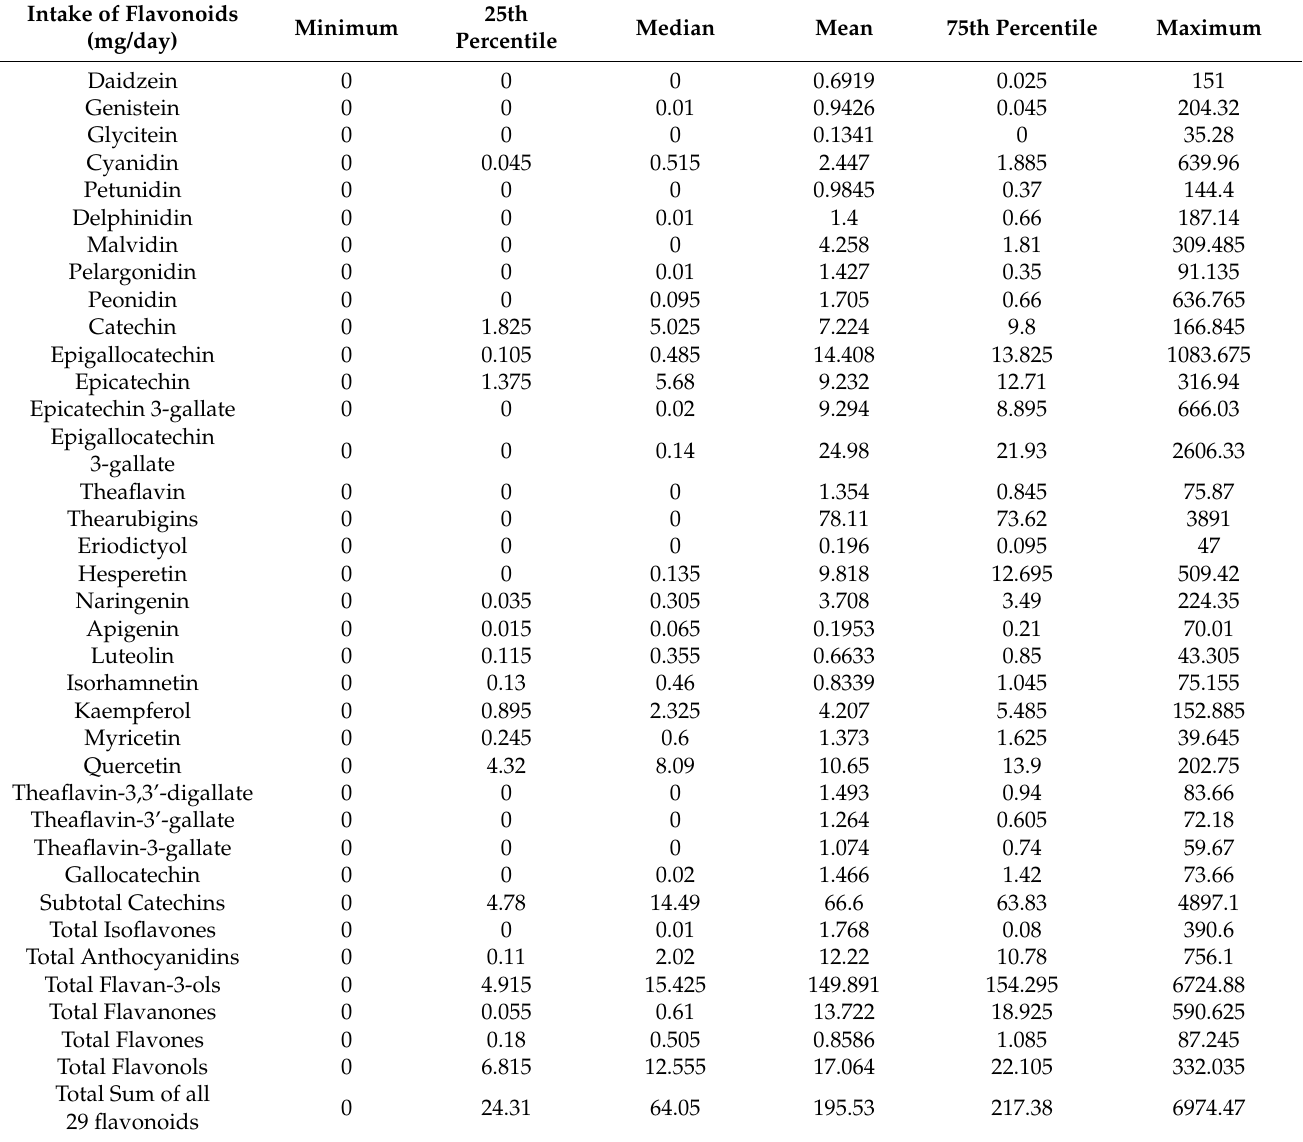
Table 1. Statistical description of flavonoid